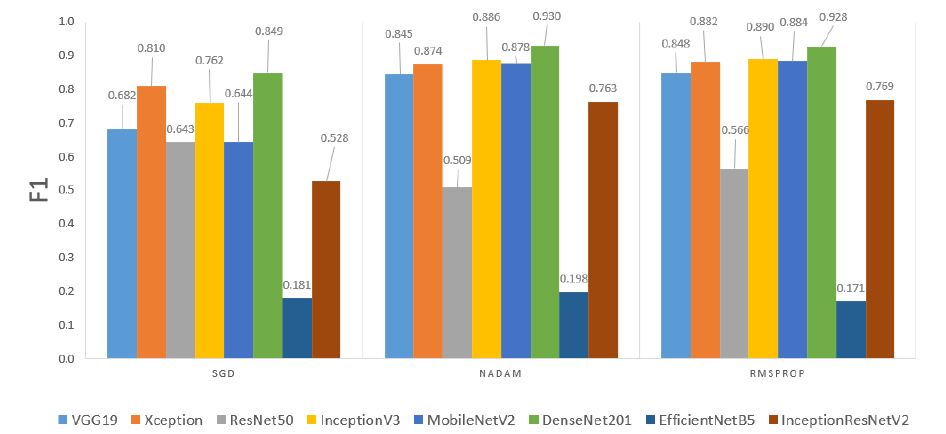
Figure 5. Summary of evaluation results by optimizer, in terms of